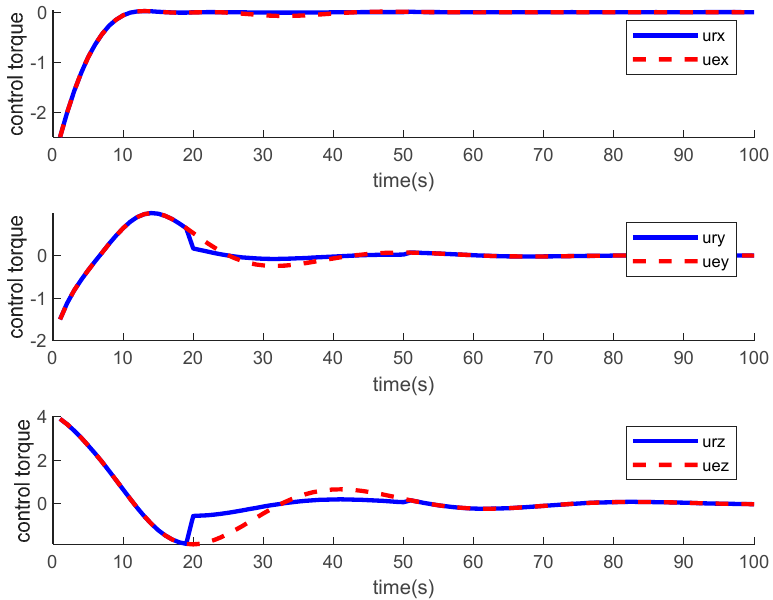
Figure 10. Curve of attitude quaternion under the controller proposed in this paper with actuator failure.